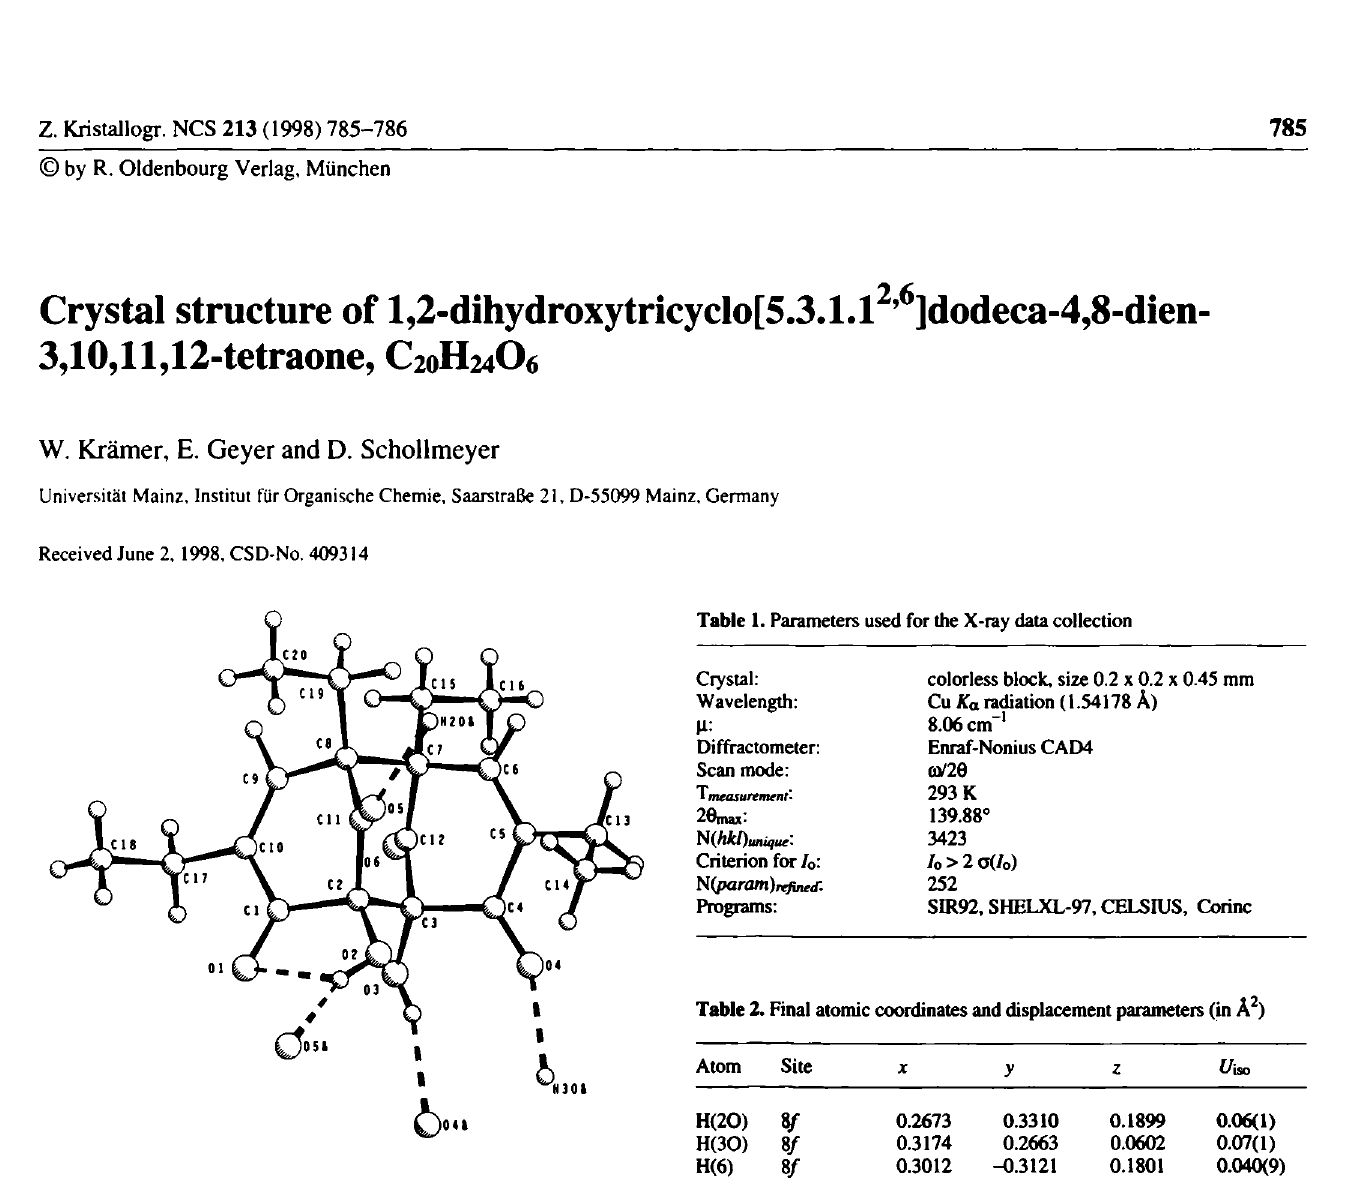
Source of material: The oxidation of 4,6-diethylpyrogallol with po- tassium nitrosodisulfonate in water at pH = 4 leads to 1,2-dihy- droxytricyclo[5.3.1.1^'Vodeca-4,8-dien-3,10,ll,12-tetraone. Crystals were optained through slow crystallization from ether. X-ray diffraction shows the carbonyl bridges in trans positon.